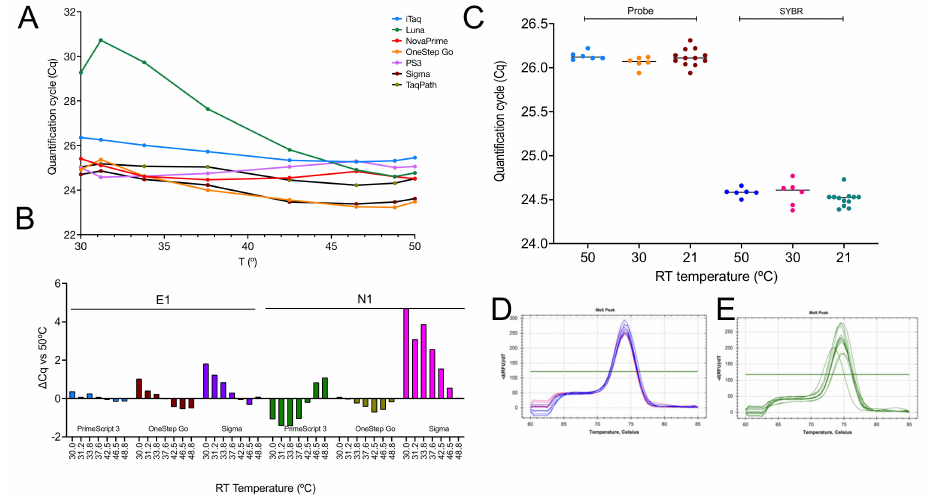
Figure 7. RT temperature gradients demonstrating low-temperature transcription by RTases. ( A ) Plot of Cqs vs. RT temperature gradient for E1 amplified by seven 1-step master mixes. ( B ) ∆ Cq values for the E1 and N1 assays recorded by three 1-step master mixes. ( C ) Cqs demonstrating the reproducibil- ity of RT results using PrimeScript 3. E1 PCR amplicons were detected with a FAM-based probe (light blue, orange and brown) or SYBR Green (dark blue, pink and green). There are six replicates at 50 and 30 ◦ C and twelve replicates at 21 ◦ C. ( D ) Melt curves for PCR amplicons obtained following RT at 50 ◦ C (dark blue) and 30 ◦ C (pink). ( E ) Melt curves for PCR amplicons obtained following RT at 21 ◦